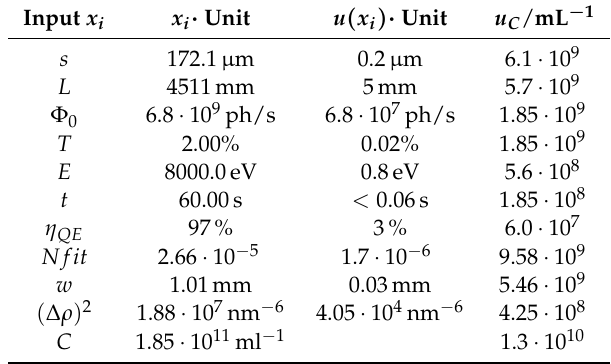
Table 3. Uncertainty budget for small angle X-ray scattering (SAXS) for the Au30